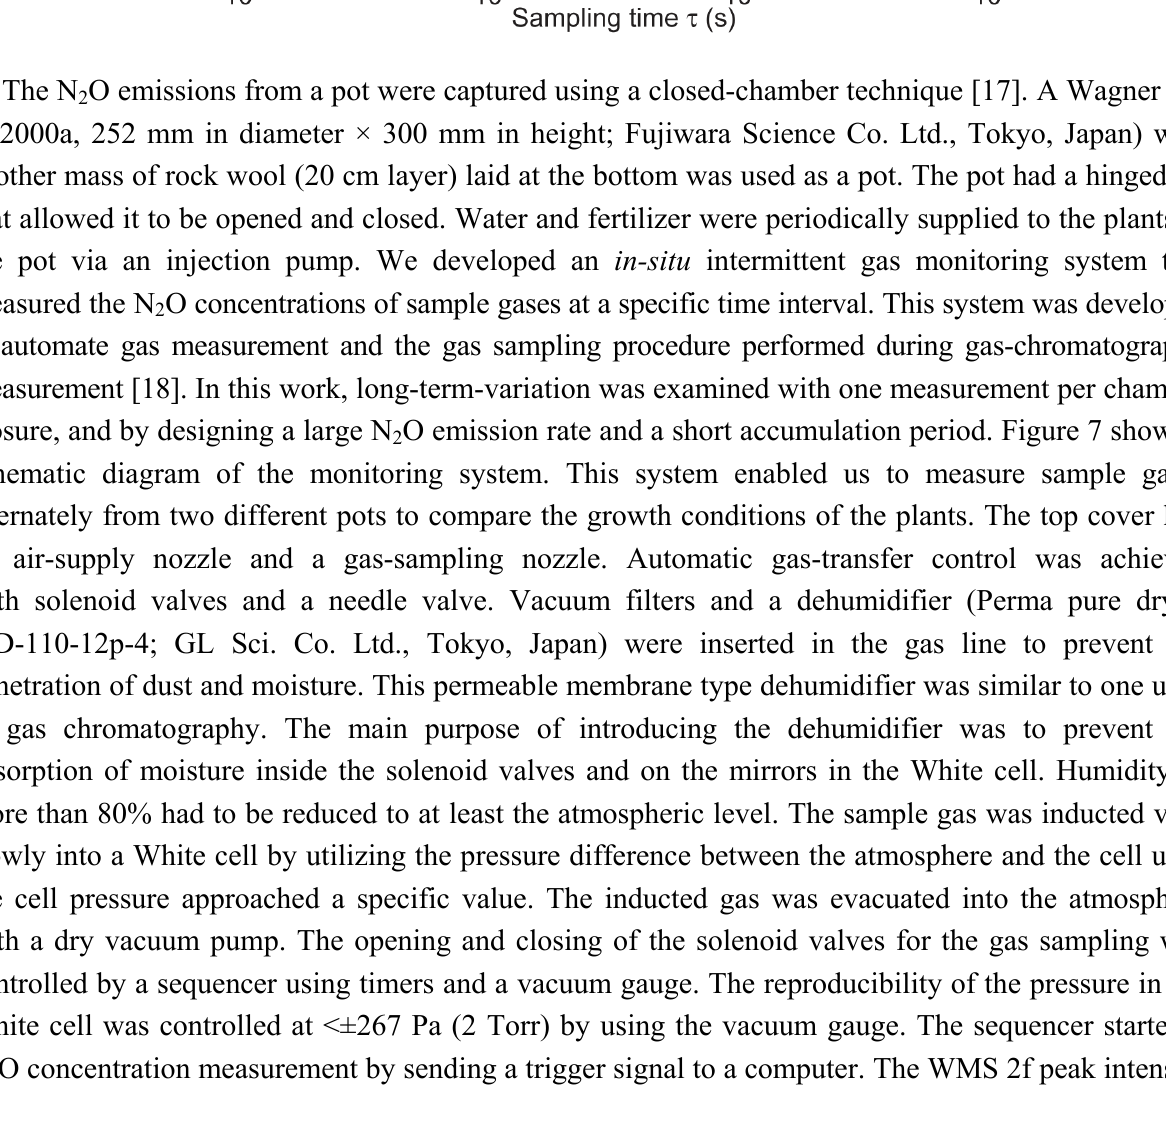
O of air in the laboratory 2